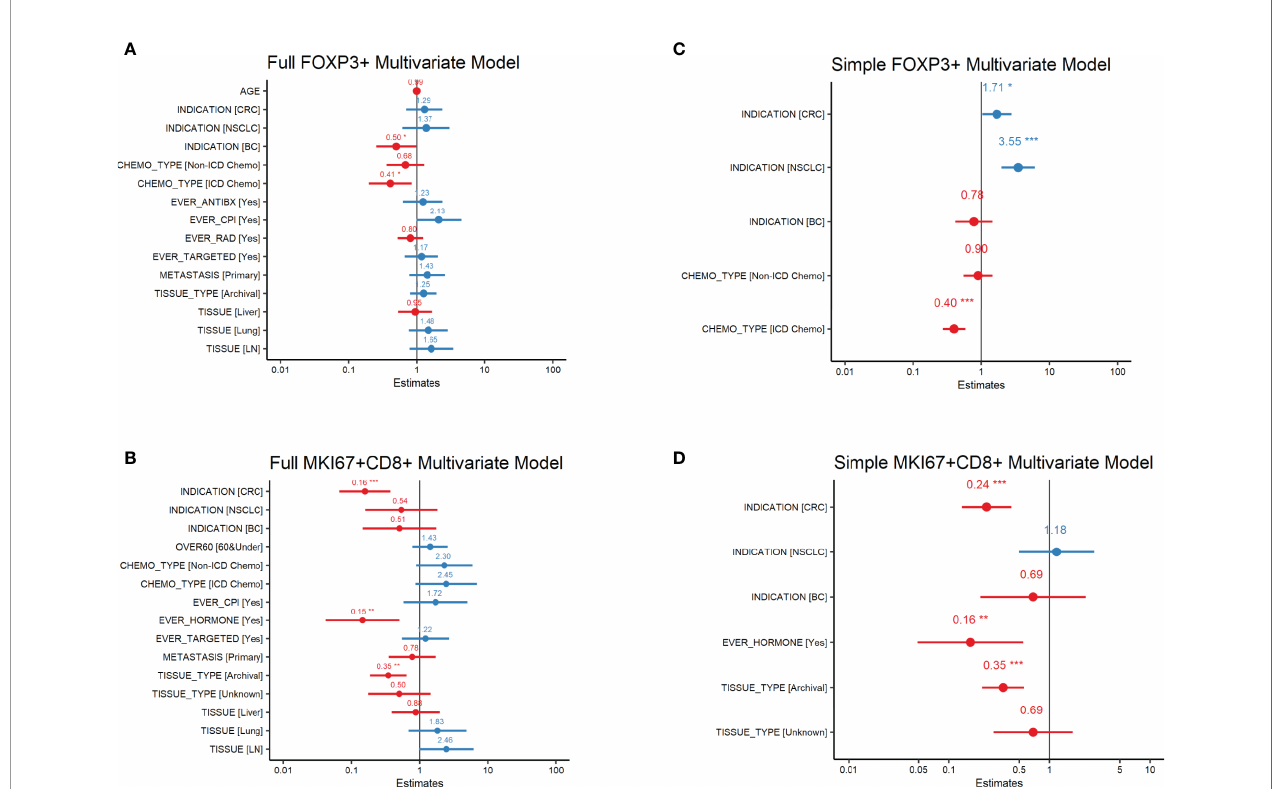
FIGURE 1 | FoxP3+ and MKi67+CD8+ Multivariate Regression Analysis Forest plots of FoxP3+ (regulatory T-cells) or MKi67+CD8+ (proliferating CD8 T- cells) Multivariate Regression Analysis. Estimates are the ratio of geometric means of counts/mm 2 relative to reference level. All variables in the univariate analysis ( Supplemental Tables 1A, B ) signi fi cant at the p=0.1 level or with an effect size of >2 or <0.5 were included in the full multivariate model (A, B) . Variables signi fi cant at the p ≤ 0.5 level in the full model were then used in the simple model (C, D) . P-values are indicated as: ‘ *** ’ 0.001 ‘ ** ’ 0.01 ‘ * ’ 0.05.